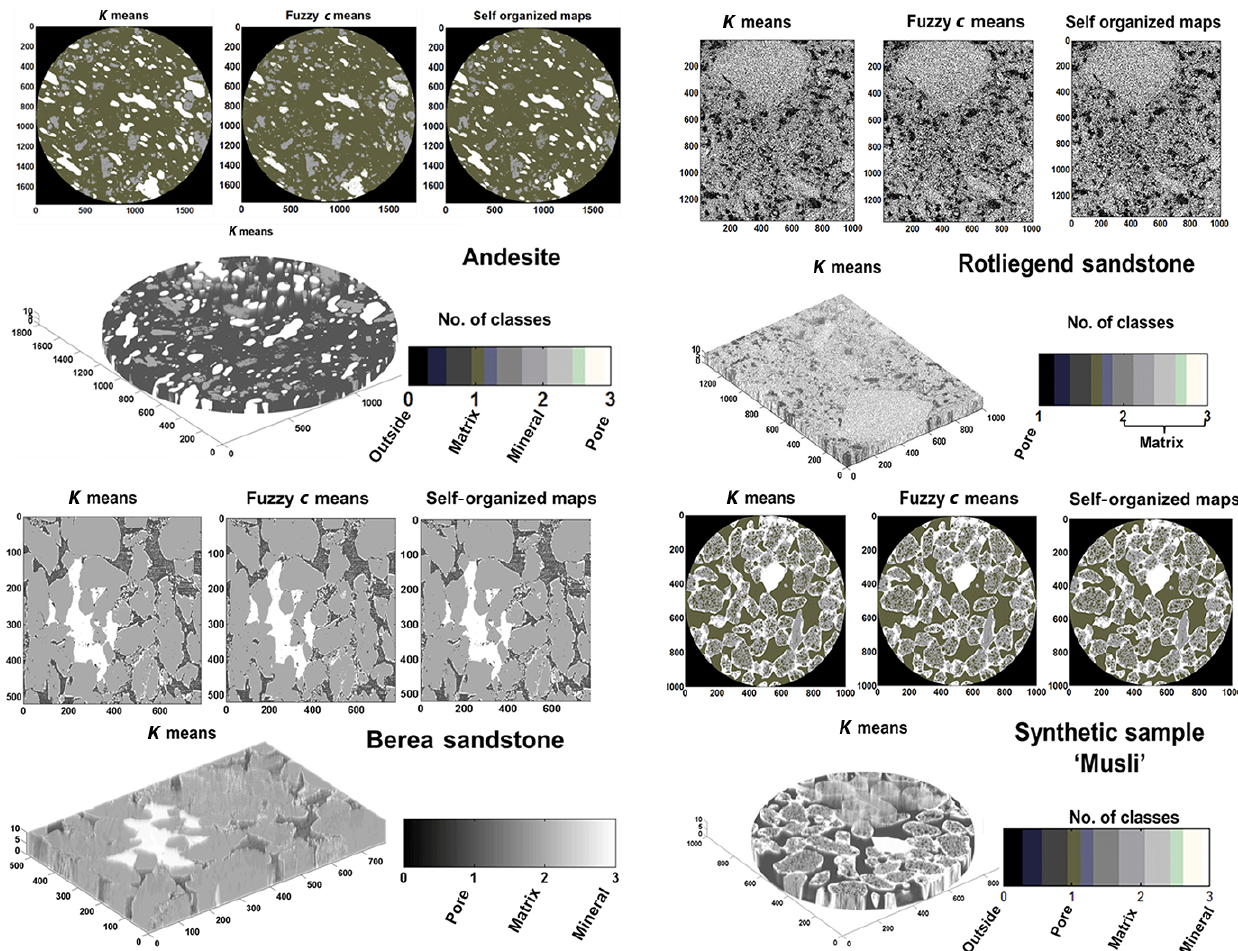
Figure 4. The top, middle and last panel show the 2-D segmented images and volume rendered plots of respective samples using unsupervised networks (andesite figure has been modified after Chauhan et al.,